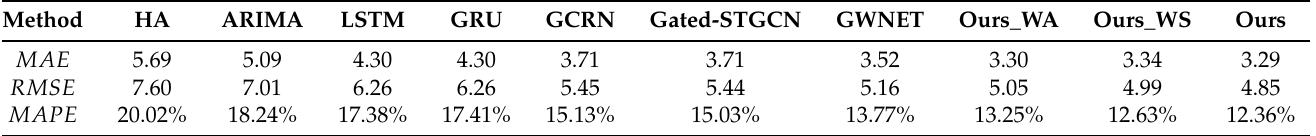
Table 3. The traffic forecasting results under different models with 120 min forecasting